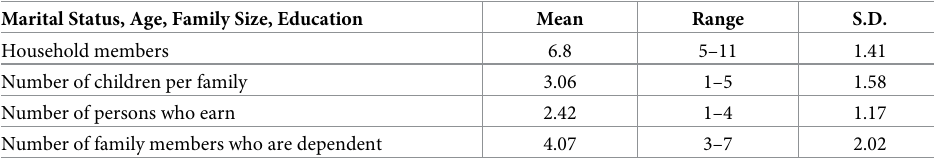
Table 3. Descriptive statistics of demographic